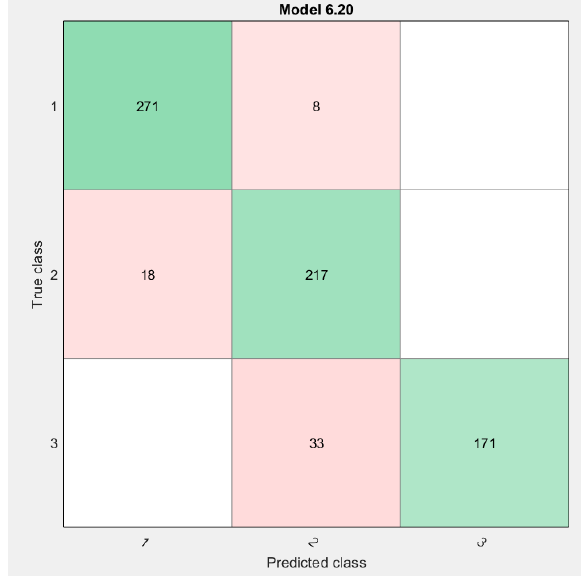
Figure 4. Confusion matrix for each classifier. Order of appearance of sub-figures (from left to right): a = Decision Tree (Model 6.1), b = Linear Discriminant Analysis (Model 6.4), c = Quadratic Discrimi- nant Analysis (Model 6.5), d = Linear Support Vector Machine (Model 6.6), e = Quadratic Support Vector Machine (Model 6.7), f = Cubic Support Vector Machine (Model 6.8), g = Gaussian Support Vector Machine (Model 6.10), h = K-Nearest Neighbor (Model 6.15), i = Boosted Tree Ensemble (Model 6.18), j = Bagged Tree Ensemble (Model 6.19), and k = Subspace Discriminant Ensemble Learner (Model 6.20).